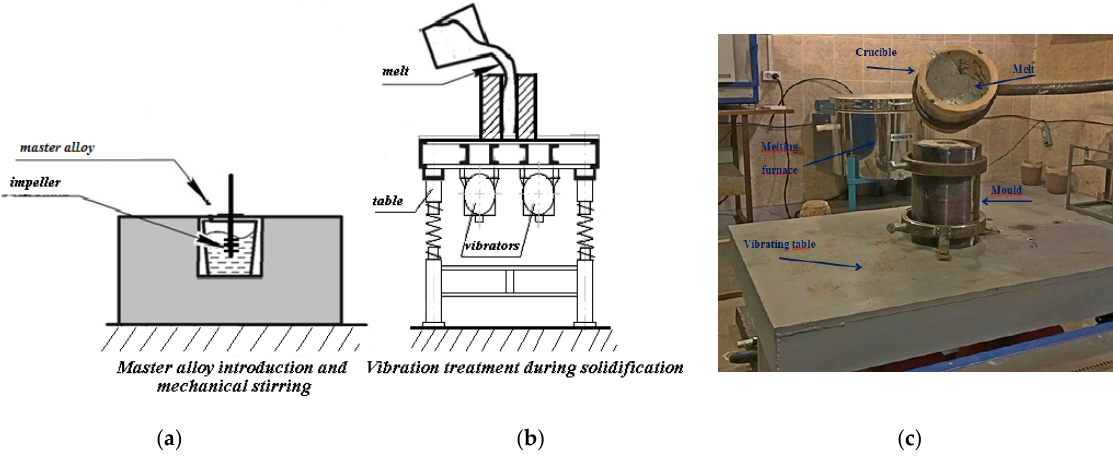
Figure 1. Scheme of vibration treatment on the melt. ( a ) master alloy introduction and mechanical stirring, ( b ) vibration treatment during solidification, ( c ) illustration of experimental apparatus for the mechanical vibration during the casting process.